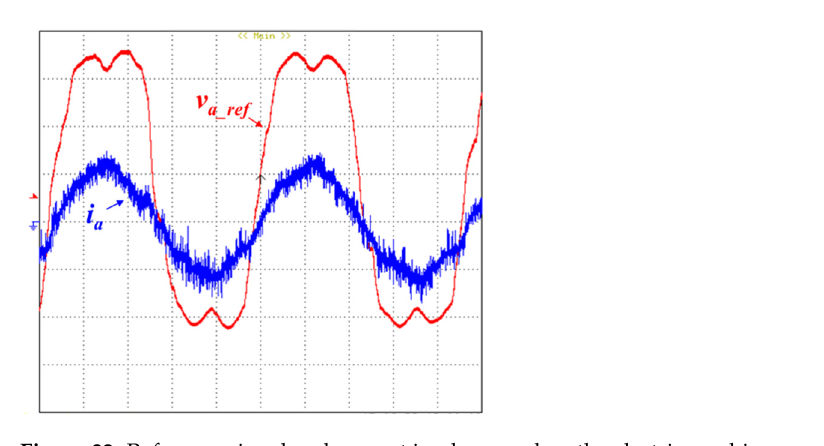
Figure 31. Three-phase currents and voltages when the electric machine operates with a 45 Nm mechanical load (current: 20 A/div; voltage: 20 V/div; time: 10 ms/div). mechanical load (current: 20 A/div; voltage: 20 V/div; time: 10 ms/div).